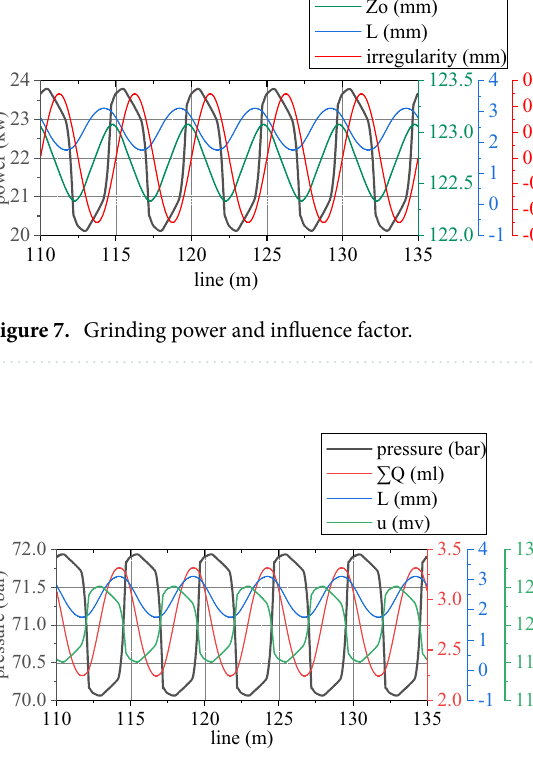
Figure 8. Pressure of rodless cavity and influencing